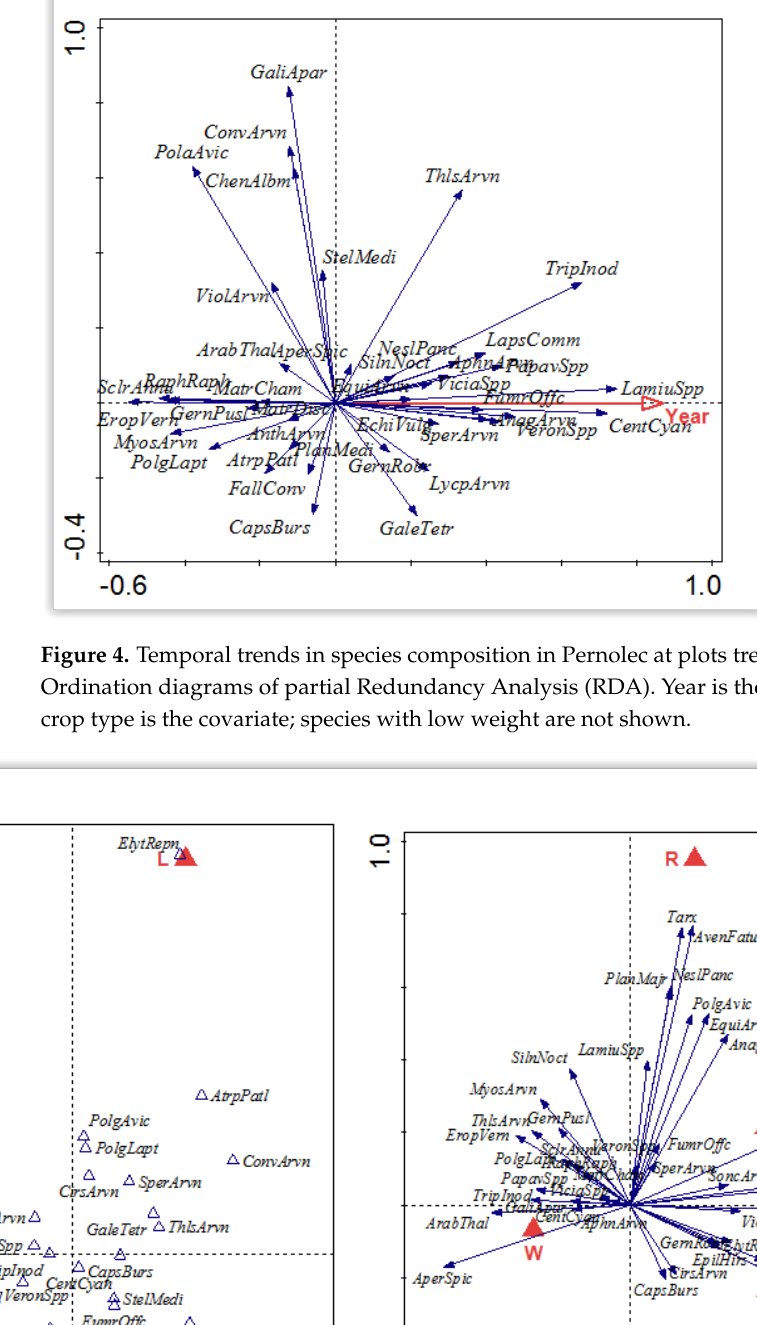
Figure 3. Temporal trends in species composition in Pernolec in multi-crop rotation. Ordination diagrams of partial Redundancy Analysis (RDA) with untreated plots ( right ) and targeted treatment with herbicide combination ( left ). Year is the explanatory variable and crop type is the covariate; species with low weight are not shown.